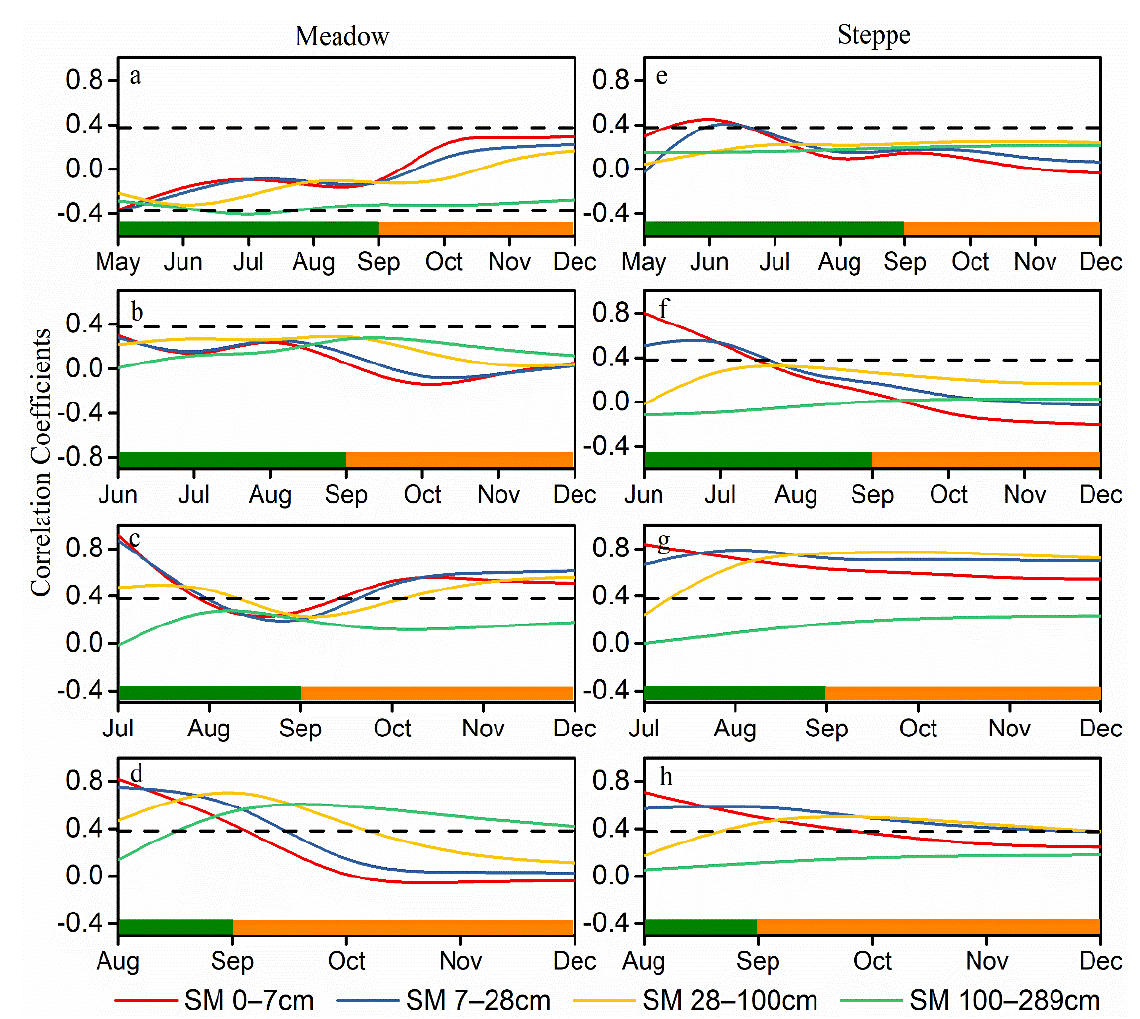
Figure 7. Lagged correlation between precipitation from May to August and soil moisture (SM) in different layers in the meadow ( a – d ) and the steppe ( e – h ). Lines in ( a – h ) are B-spline curves derived from the correlation coefficient between monthly precipitation in May-August and monthly soil moisture at different depths (0–7 cm, 7–28 cm, 28–100 cm, and 100–289 cm) in the meadow ( a – d ) and the steppe ( e – h ), respectively. Green and yellow bars are growing and non-growing seasons on the TP, respectively. The dashed line is the 0.1 significance level.